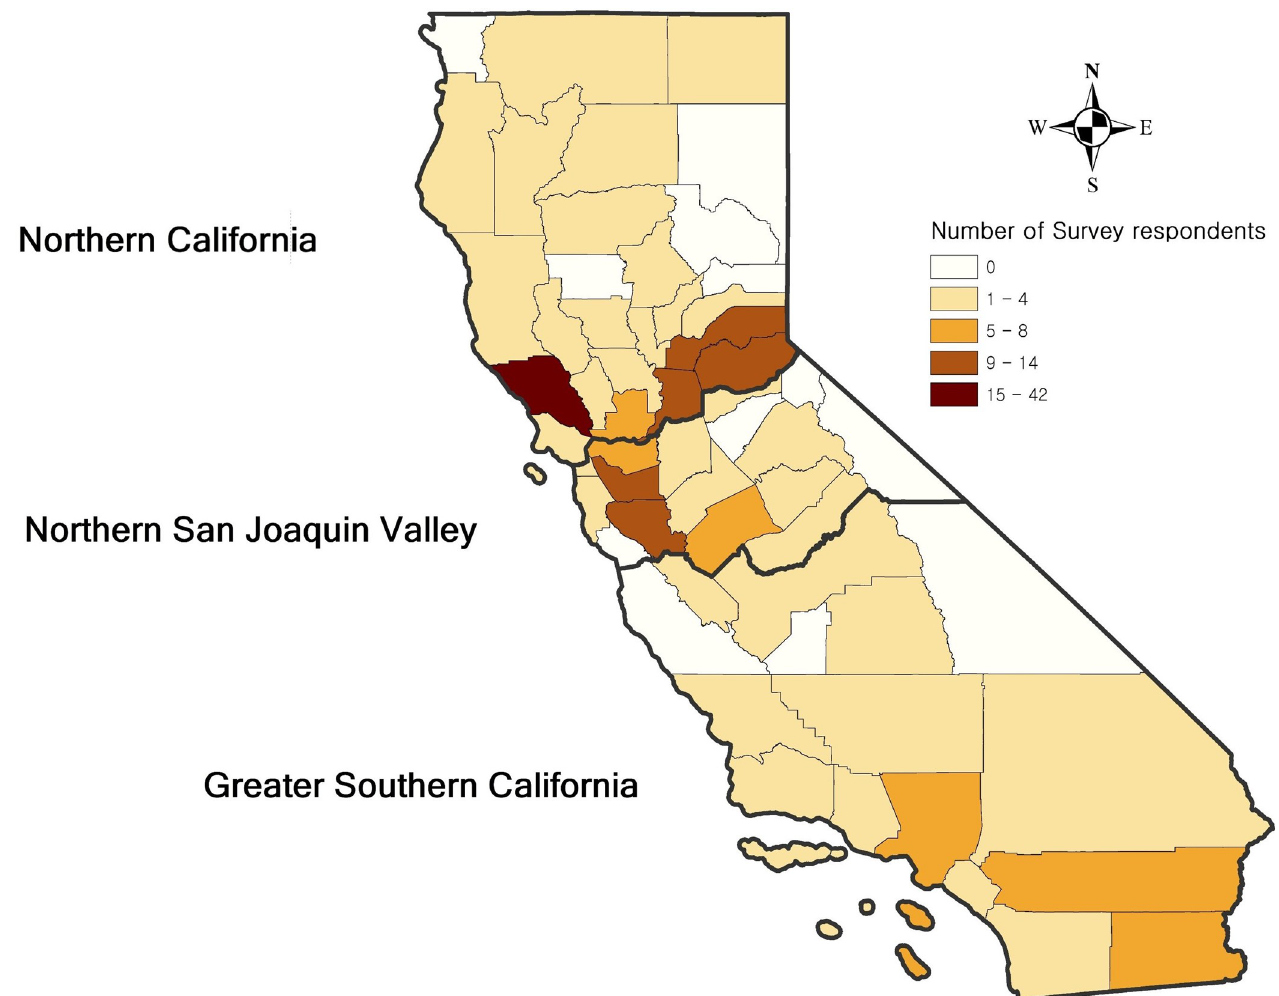
Fig 1. Geographical distribution of respondents’ premises by counties in California (n = 242).